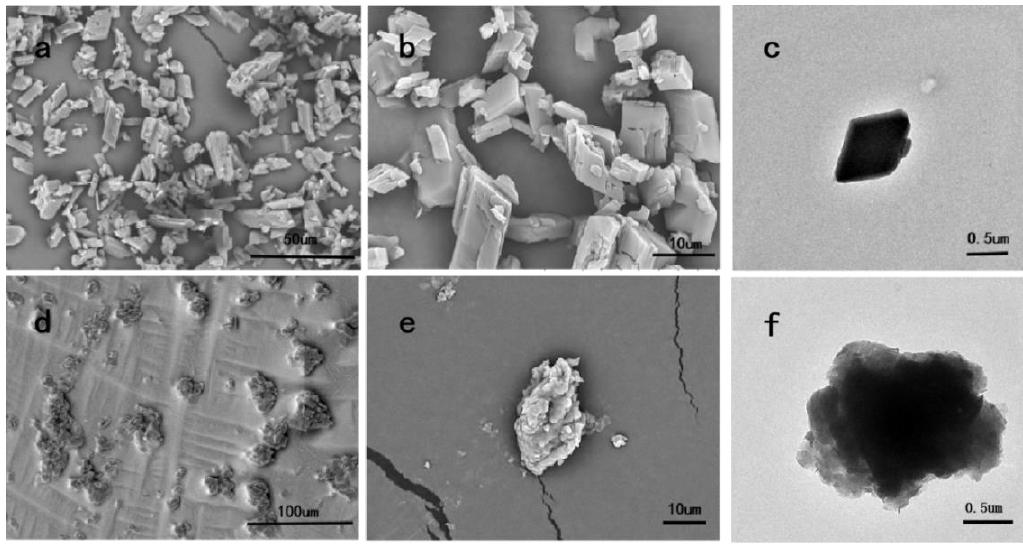
Figure 1. SEM and TEM images of single-layered microcapsules ( a – c ) and double-layered microcapsules ( d – f ).